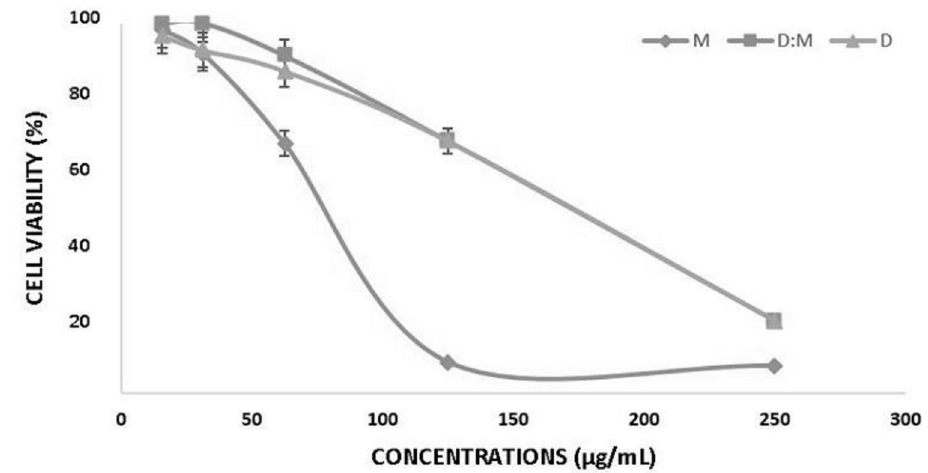
Figure 1. Breast cancer T47D cell viability after treatment with extracts of Ancorina sp. Methanol (M), Dichloromethane:Methanol (D:M) and Dichloromethane (D). Error bar shows standard